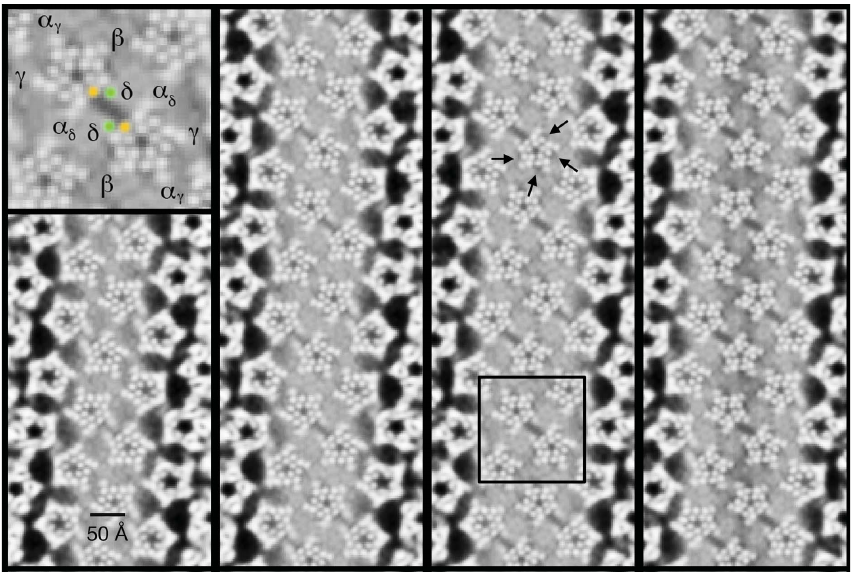
Figure 3 Sections tangential to the tube axis spanning the outer phospholipid headgroup region of the lipid bilayer. Low-density patches are present in the space between the (cid:2) subunits of neighbouring receptors (see, for example, the box in the third panel) and at the M1/M4 lipid–helix interface of the remaining four subunits (arrows). Inset: enlargement of the boxed dimer of receptors and the central low-density microdomain, identifying individual subunits and the M1 (orange) and M4 (green) helices of (cid:2) . The panels are at 2.7 A˚ intervals from the outermost side (left) to the innermost side of the headgroup region. Inverted